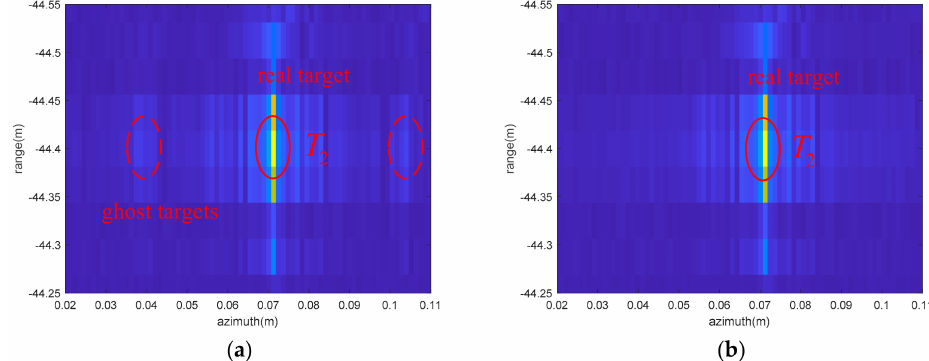
Figure 35. Partial enlargement of T 2 ( a ) without compensation and ( b ) with compensation.